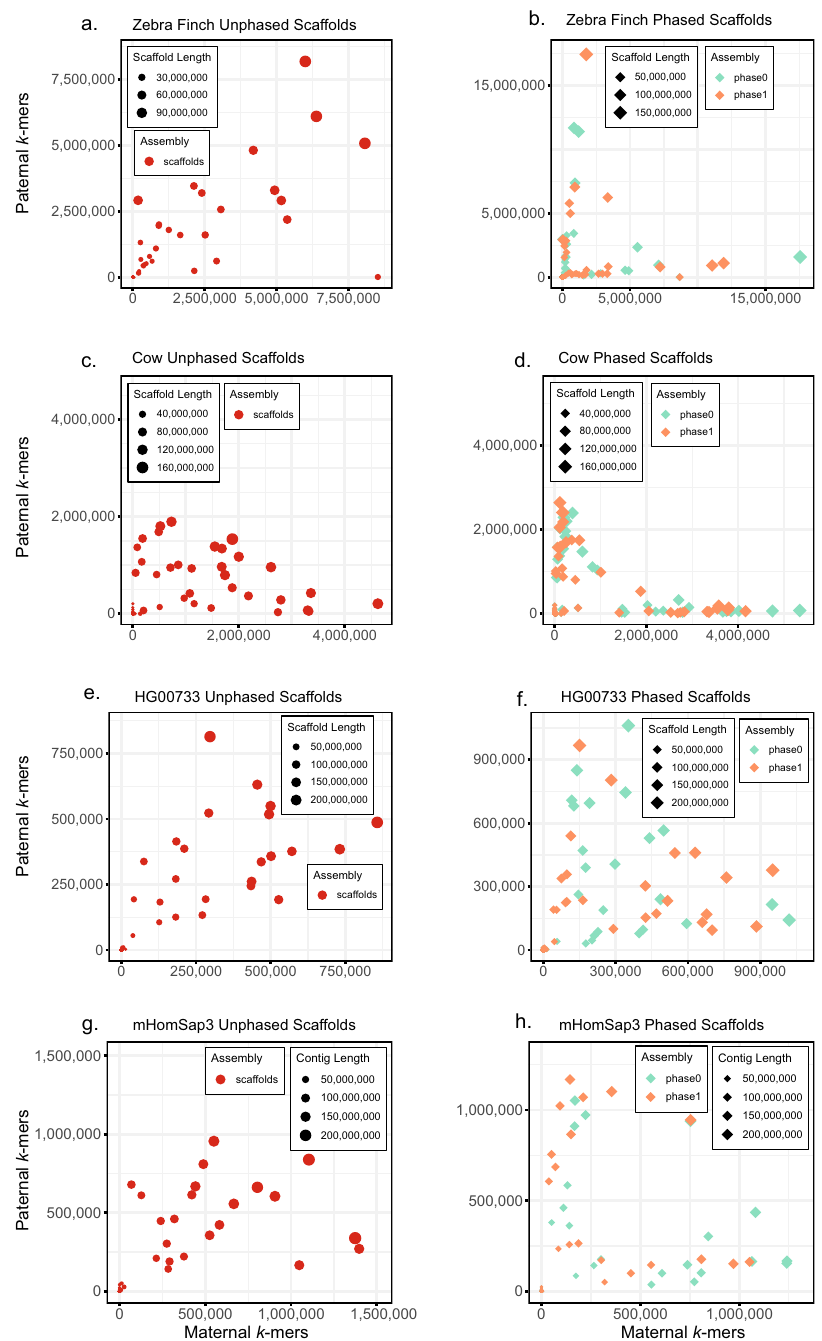
Fig. 3 Phasing accuracy of scaffolds before (left) and after applying FALCON-Phase (right). Parent-speci fi c k -mers from mother are on the x -axis and father on the y -axis. Scaffold size is indicated by size of the data point and well-phased contigs lie along the axes. Only the phase 0 contigs from FALCON- Phase were scaffolded. Scaffolds after a second round of phasing by FALCON-Phase show greater separation, indicating each scaffold contains a higher proportion of markers from one parent. a Zebra fi nch scaffolds before phasing; b zebra fi nch scaffolds after phasing; c cow scaffolds before phasing; d cow scaffolds after phasing; e HG00733 scaffolds before phasing; f HG00733 scaffolds after phasing; g mHomSap4 scaffolds before phasing; h mHomSap3 scaffolds after